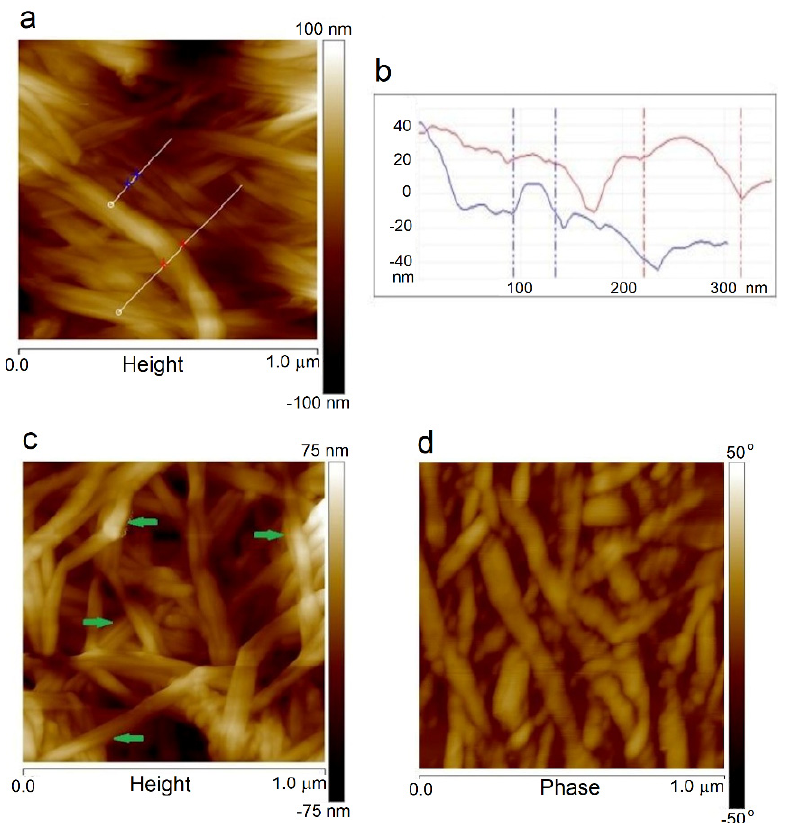
Figure 7. Height image of H-2 ( a ) with the fibers marked for which thickness was measured, as shown in the cross-section ( b ); height image of I-2 in which the arrows indicate the thickening of the PVA coated fibers ( c ); and phase image of S-2 showing darker and lighter parts of the fiber due to differences in order ( d ).